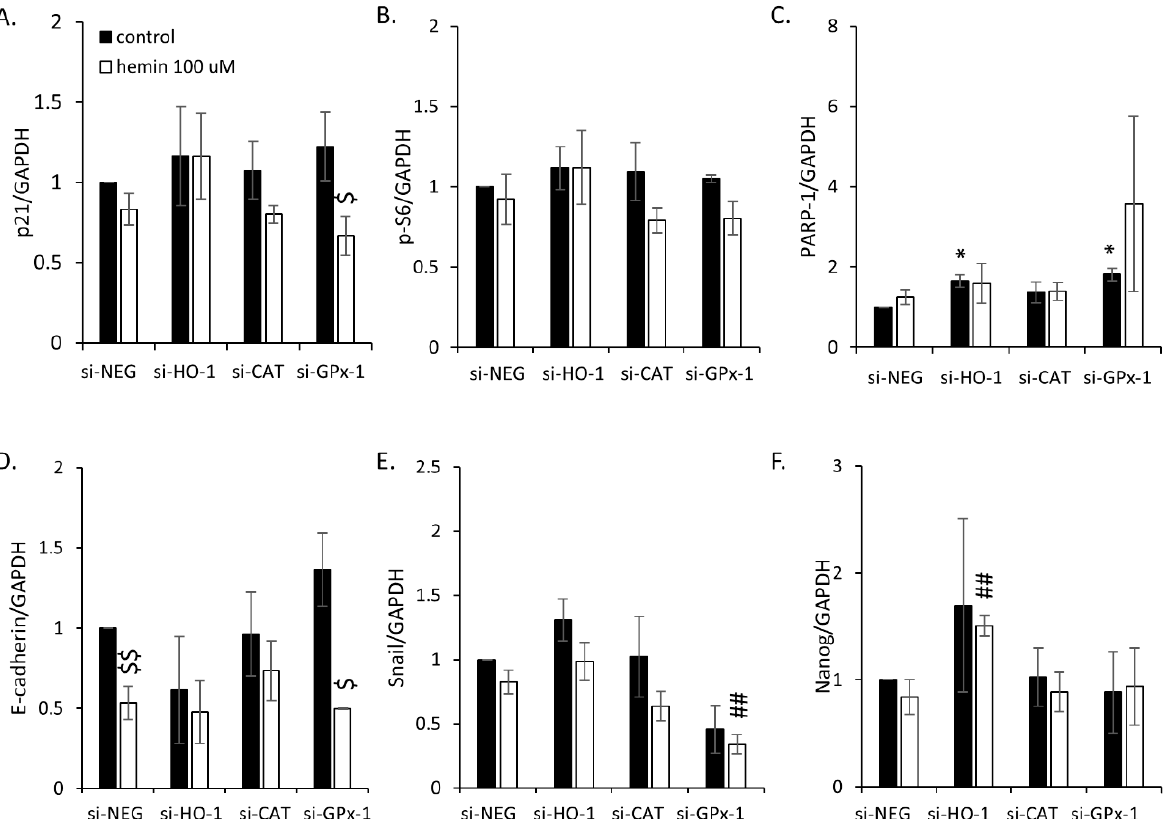
Figure A6. Evaluation of the protein expression in HCT116 cells, where genes encoding antioxidative enzymes HO-1, CAT, and GPx-1 were silenced with the use of siRNAs: cell cycle inhibition and EMT markers. Cells were treated with 2.5 µ M IRINO and exposed to 100 µ M hemin. Control cells were subjected to IRINO and NaOH. Cells were incubated with drugs for 24 h; after that time, the medium was removed and the cells were cultured in a drug-free medium for 4 days. Quantification is based on the densitometry analysis performed with the use of ImageJ software. Data are shown as the ratio of the protein amount to respective protein loading control (GAPDH): ( A ) p21; ( B ) p-S6; ( C ) PARP-1; ( D ) E-cadherin; ( E ) Snail; ( F ) Nanog. Each bar represents mean ± SEM, n ≥ 3; * p < 0.05—vs. siNEG control; ## p < 0.01—vs. siNEG hemin 100 µ M; $ p < 0.05, $$ p < 0.01—control vs. hemin 100 µ M.